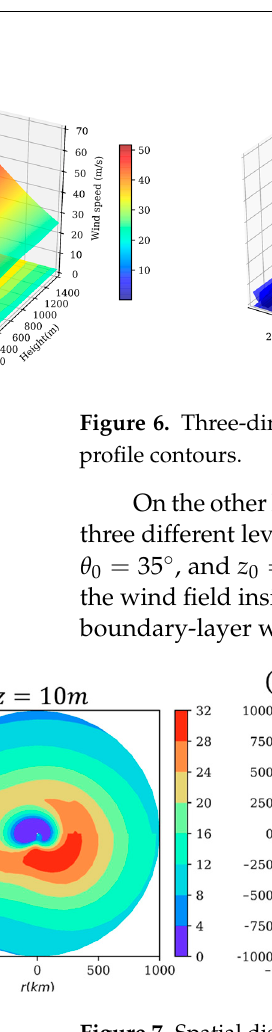
Figure 7. Spatial distribution of the ETC wind at three different altitudes: ( a ) 𝑧 = 10 𝑚 ; ( b ) 𝑧 = 500 𝑚 ; and ( c ) 𝑧 = 1000 𝑚 .